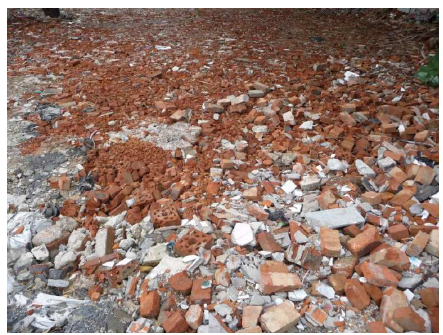
Fig. 17. The image of the terrain in the experiment